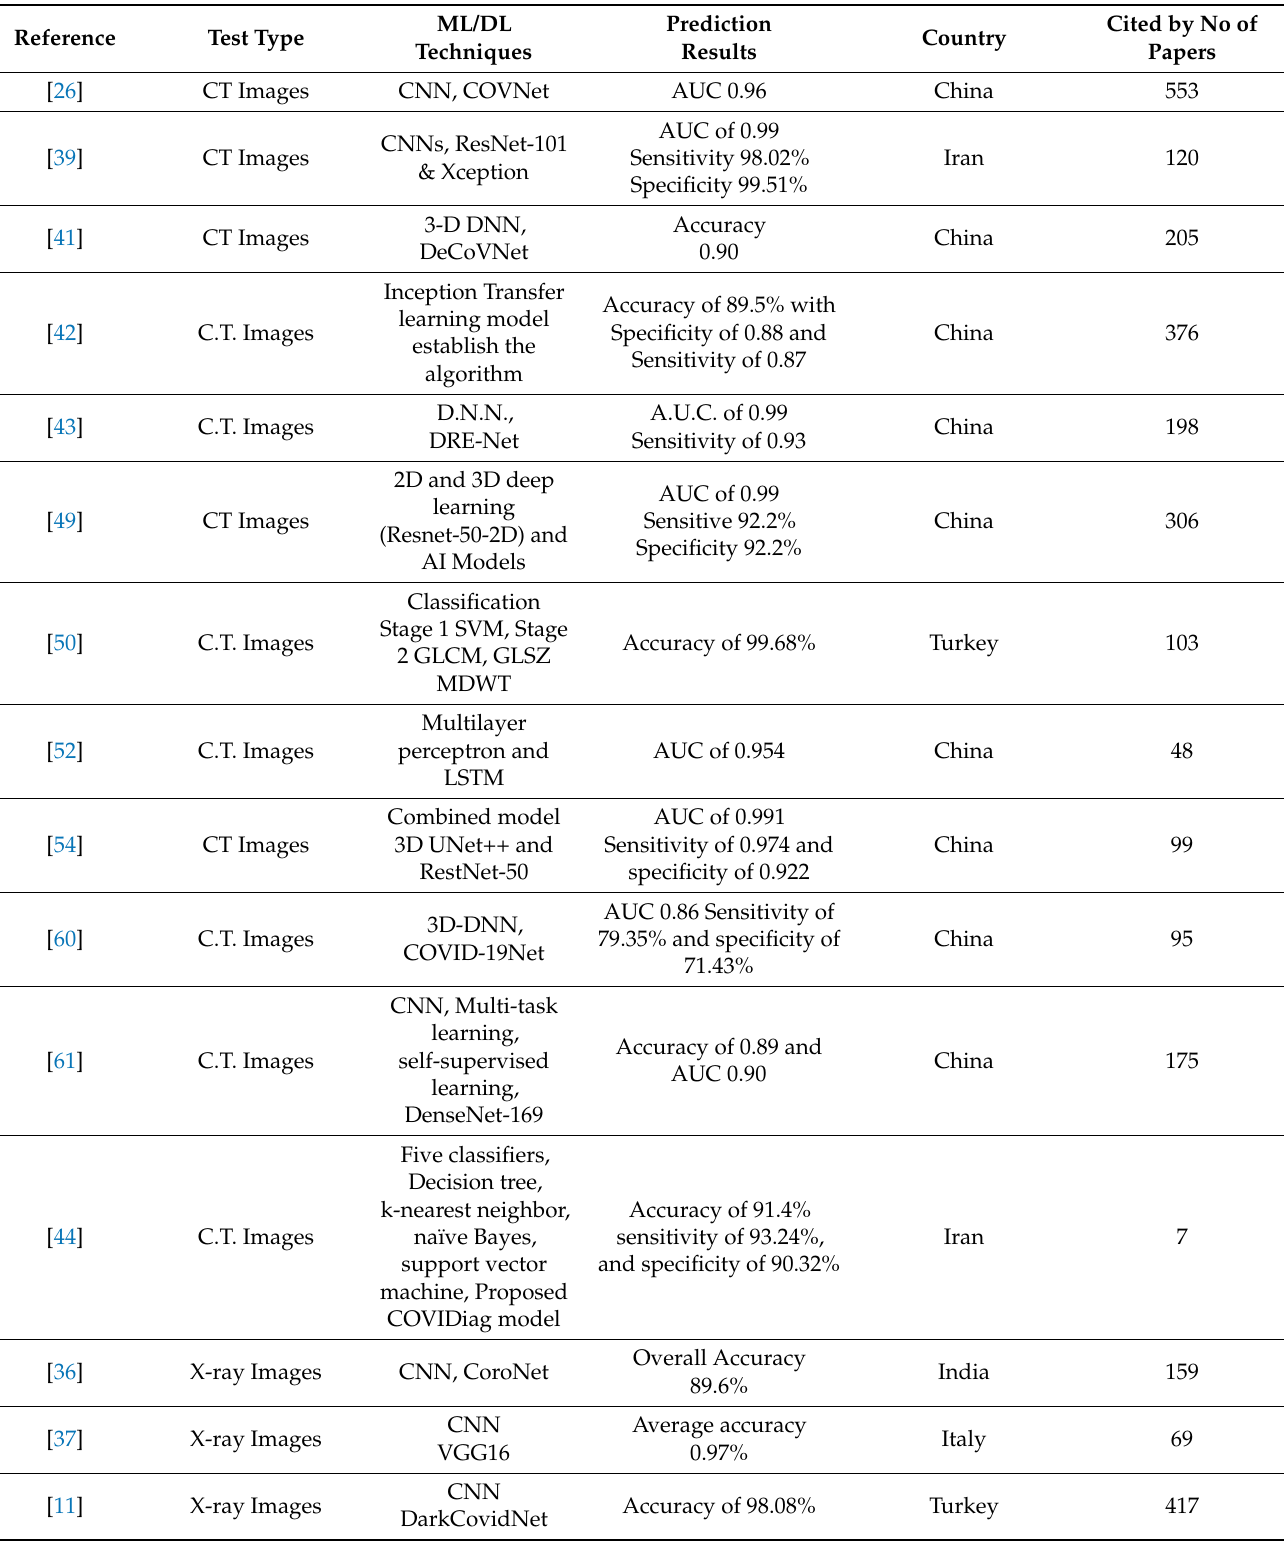
Table 2. Summary of state-of-art COVID-19 prediction